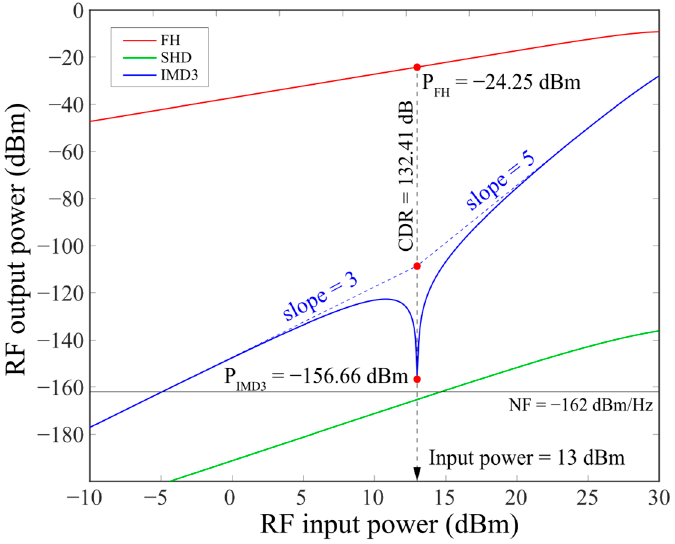
Figure 9. Output FH, SHD, and IMD3 powers versus input RF powers.